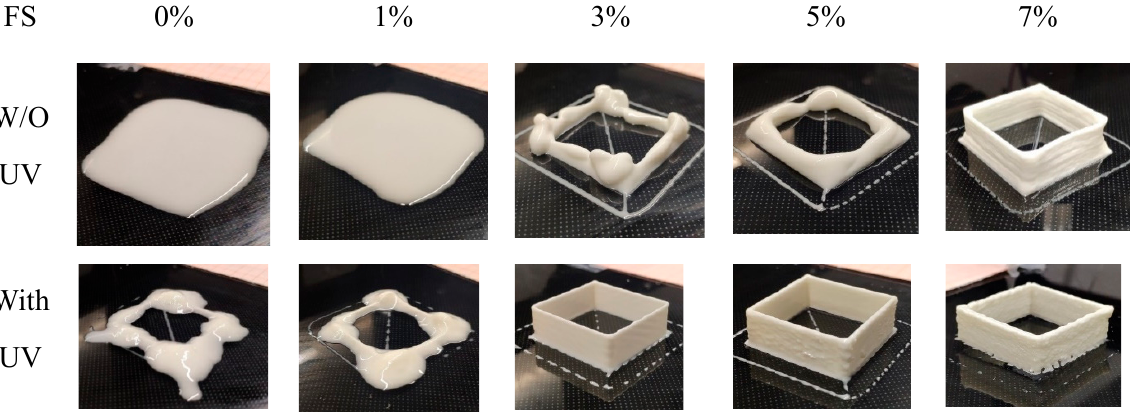
Figure 6. Printability with different amounts of fumed silica with and without UV light.